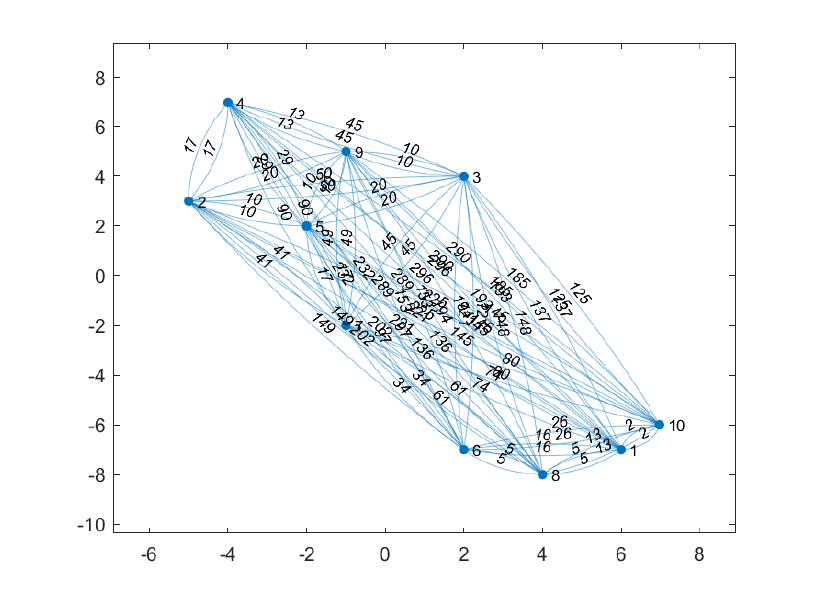
Figure 7. Nodes show that the locations of the 10 CH robots. The weight of a link shows the square of distance between the two nodes connected via that